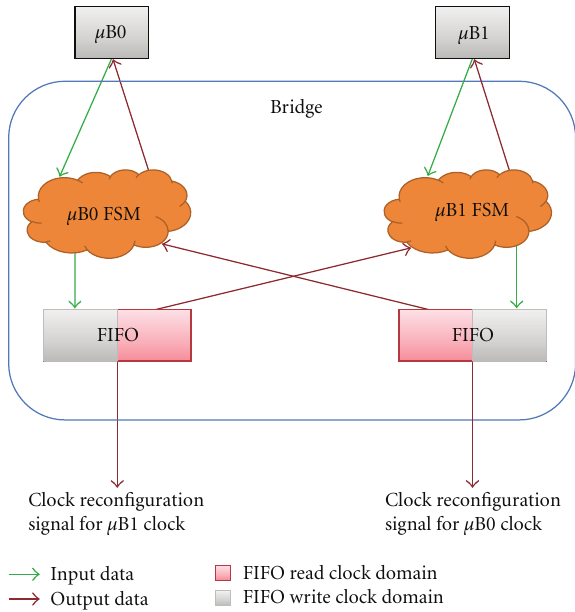
Figure 6: Internal structure of the bridge.